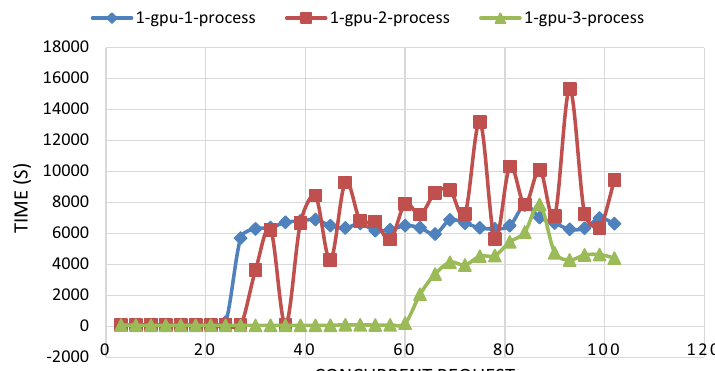
Fig. 8 Execution time (seconds) based on the concurrent request for 1 GPU